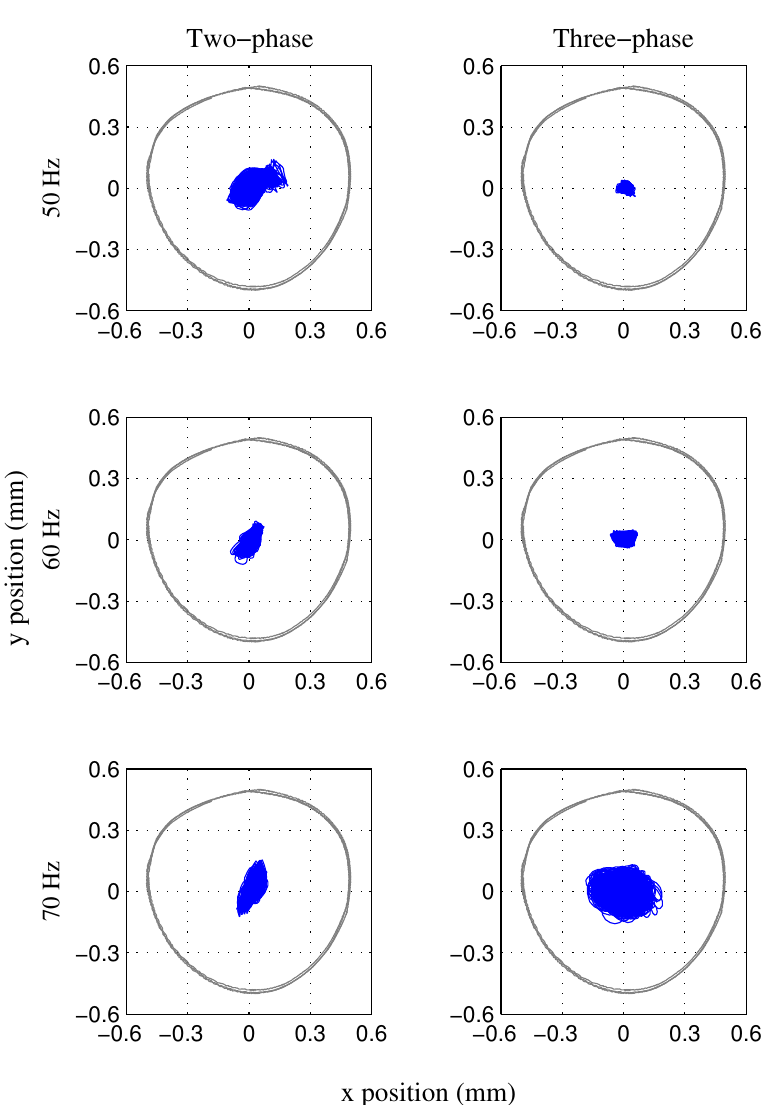
Figure 11. Responses of the proposed two-phase and conventional three-phase radial position controllers for different supply